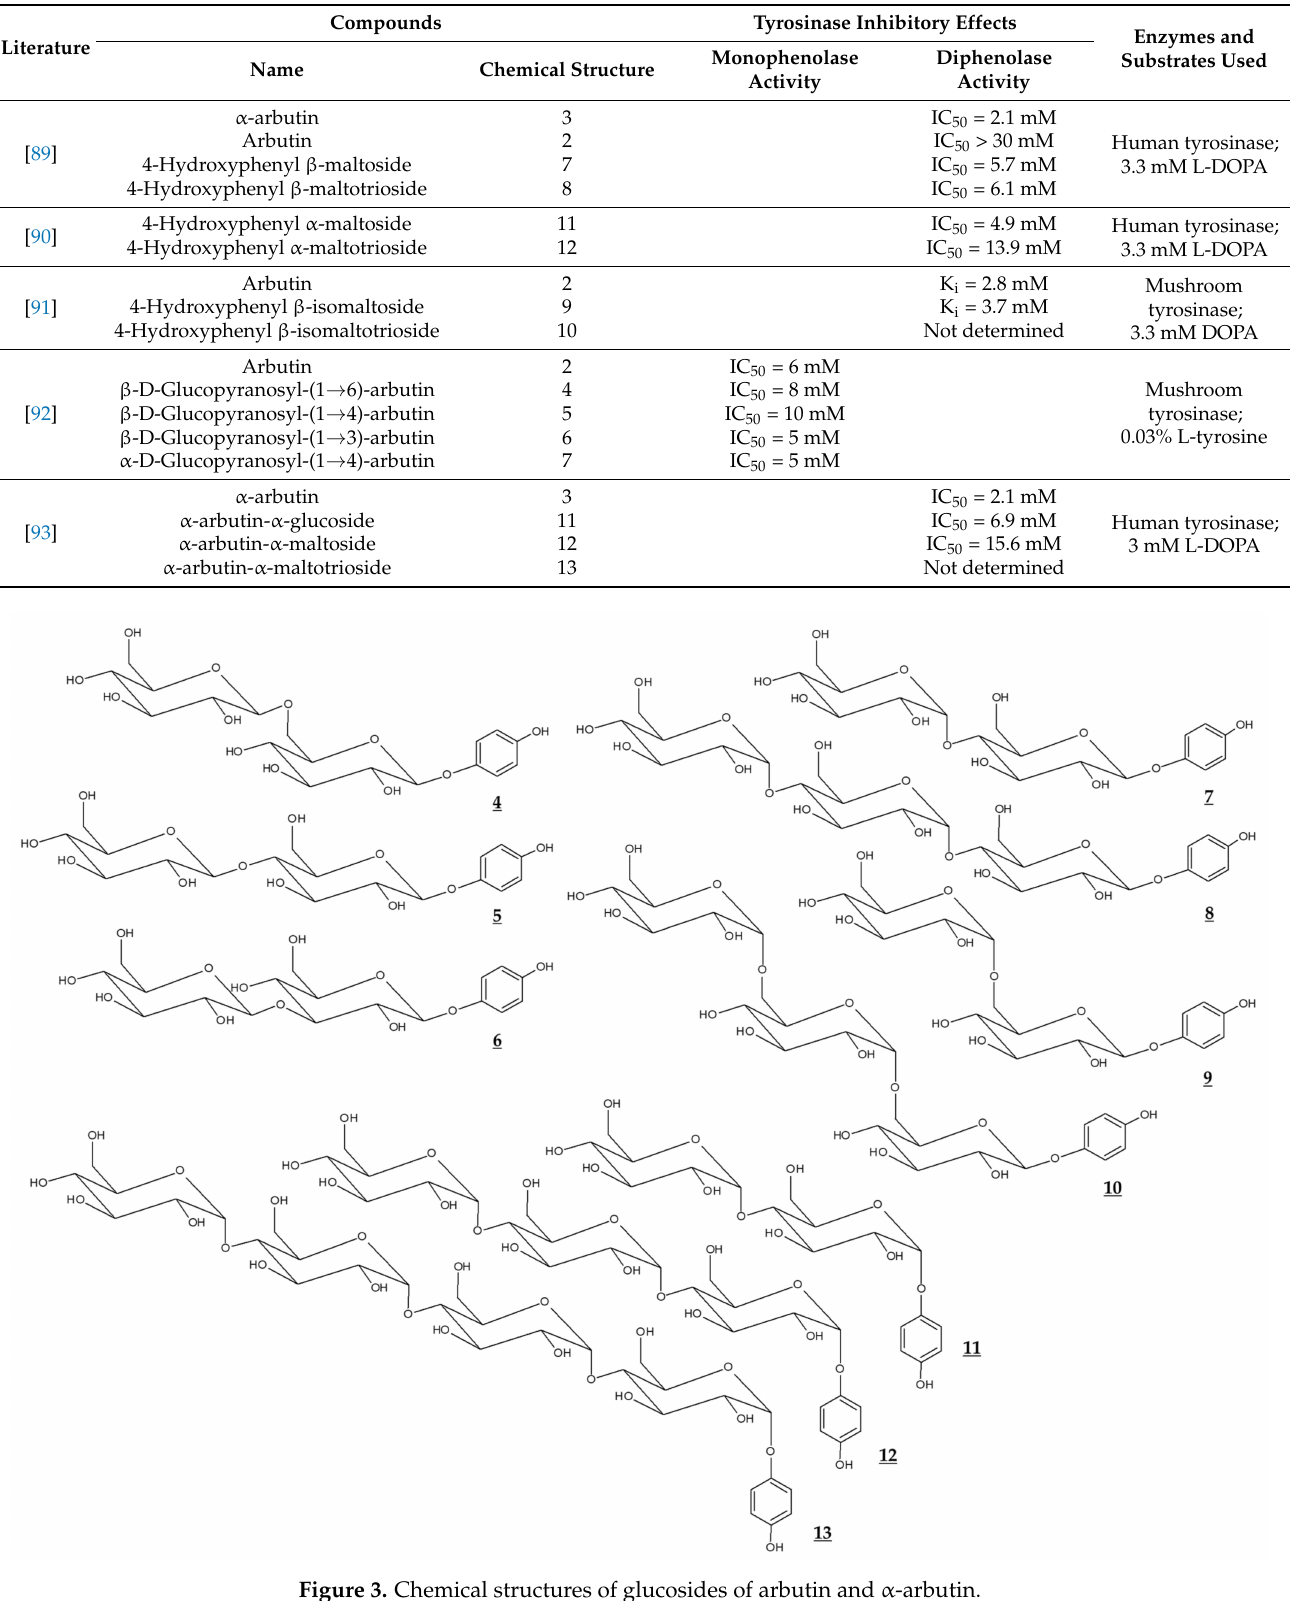
Figure 3. Chemical structures of glucosides of arbutin and α